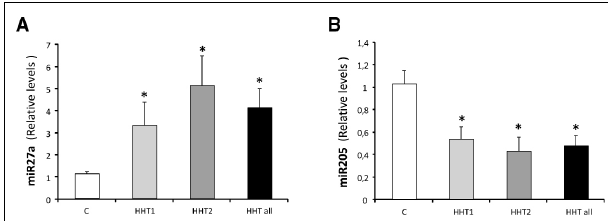
FIGURE 4 | miRNAs as HHT biomarkers in plasma. Levels of (A) miR-27a and (B) miR-205 were measured in plasma samples of a total of 24 HHT patients HHT1 ( n = 11) and HHT2 ( n = 13) and in 16 healthy controls by qRT-PCR. Data are expressed as relative miRNA levels normalized to two spikes-in C. elegans miRNAs and are expressed as mean ± SEM. * p < 0.05 vs healthy patients. Adapted from Tabruyn et al.